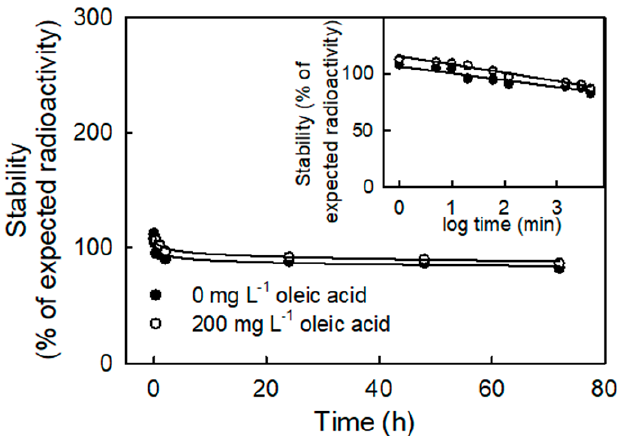
Figure 1. Stability of fatty acid solutions. Time course of change in radioactivity in the lower layers of an oleic acid solution in a scintillation vial without shaking (solution height 12 mm, solution volume 5 mL). Both solutions had 19,269 ( ± 160) dpm total radioactivity and 0 or 200 mg L − 1 of un-labelled (cold) oleic acid. Time on the x -axis is log-transformed and re-plotted in the inset. The values are means ± SEs of five replications.